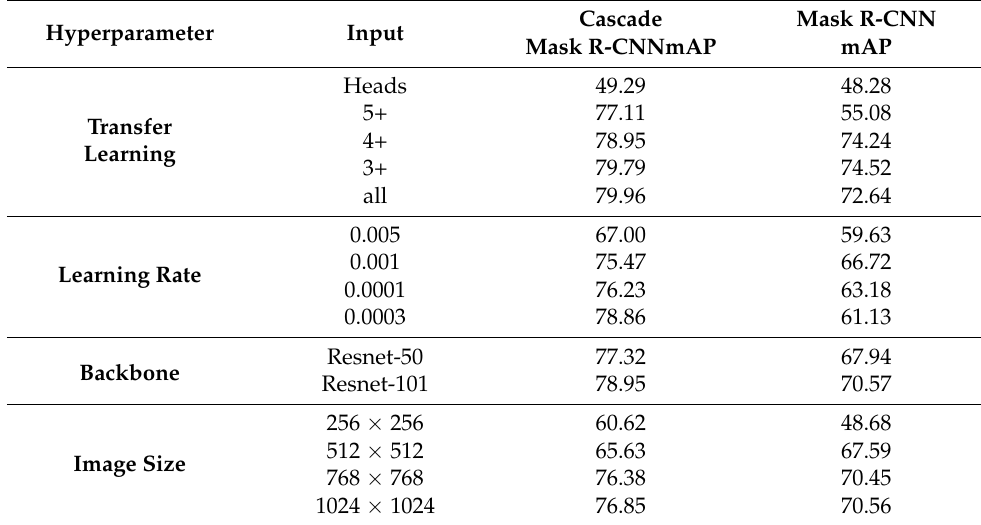
Table 1. Results of the experiment by major hyperparameters.